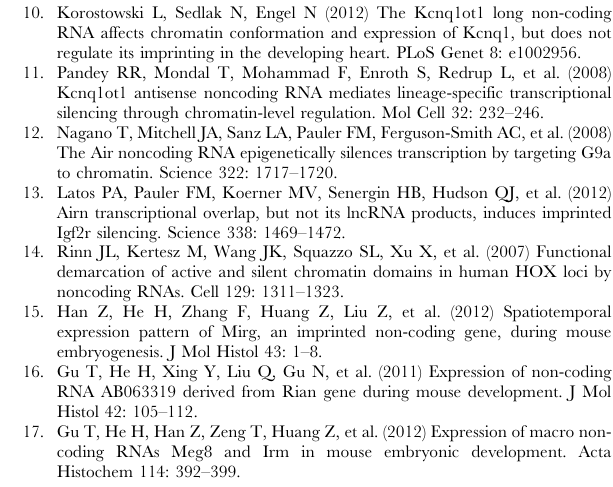
Figure S5 Chromosomal distribution of lncRNAs in the mouse genome and randomly chosen putative embry- onic brain lncRNAs for exploring expression in adult whole brain. For each chromosome, the chromosomal coordi-